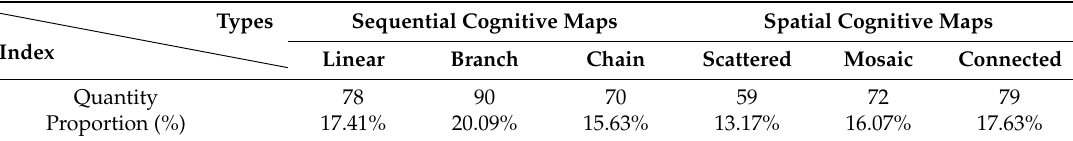
Table 5. Statistics of the cognitive